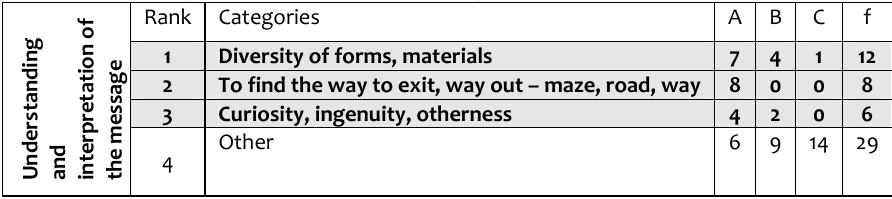
Table 11: Ranking order of categories of answers regarding understanding and interpretation of the fourth example (Richard Serra: Snake, 1994-1997).